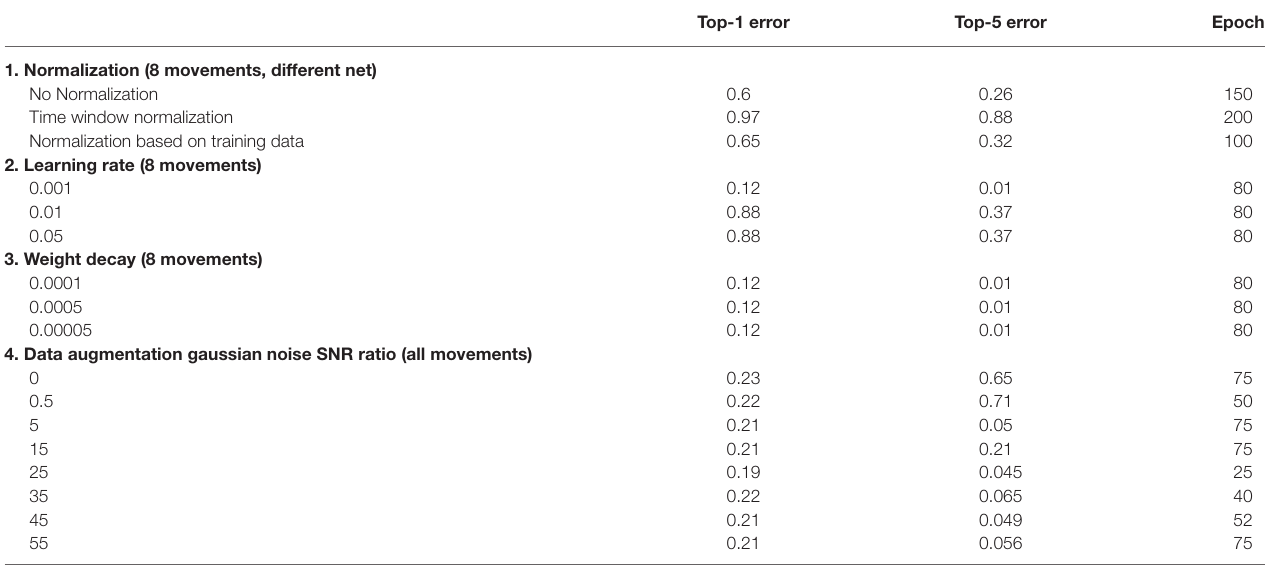
TABLE 1 | Tested pre-processing parameters and